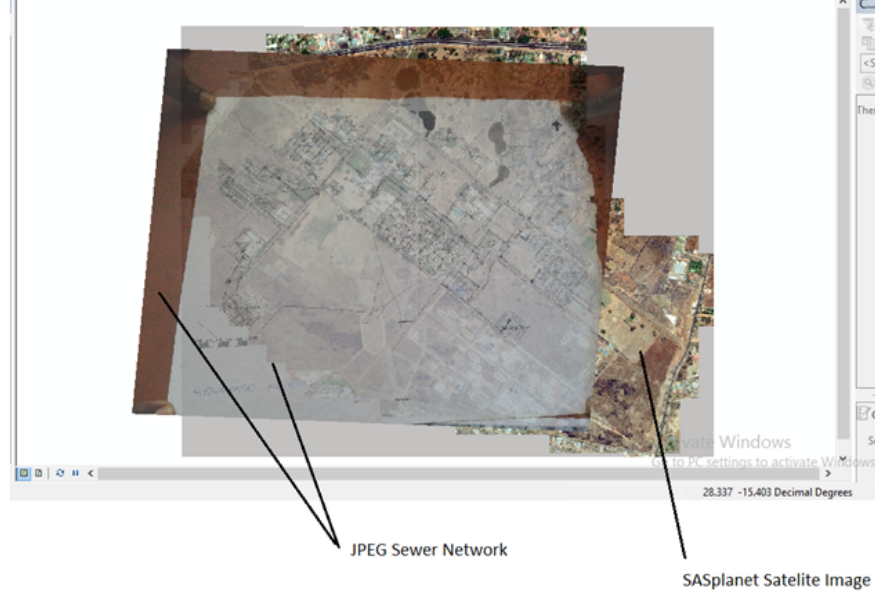
Fig. 7. Satellite Image and Sewer